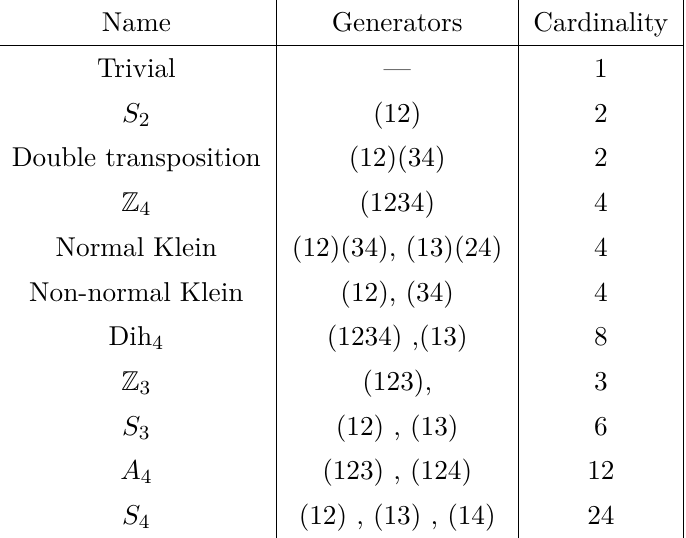
Table 4 . Subgroups of S 4